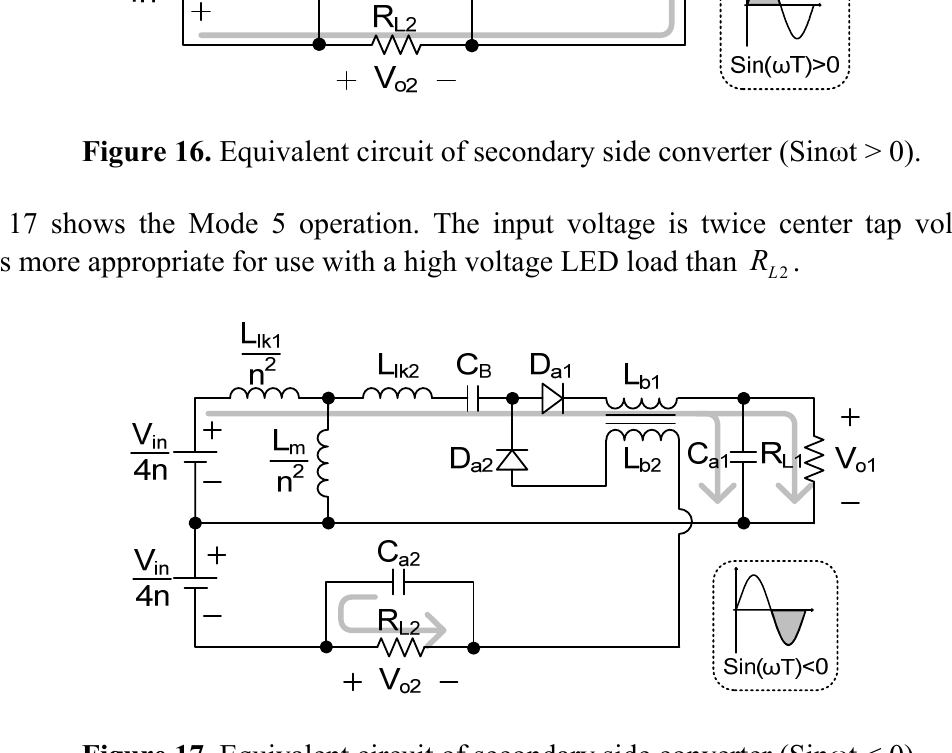
Figure 17. Equivalent circuit of secondary side converter (Sin ω t <